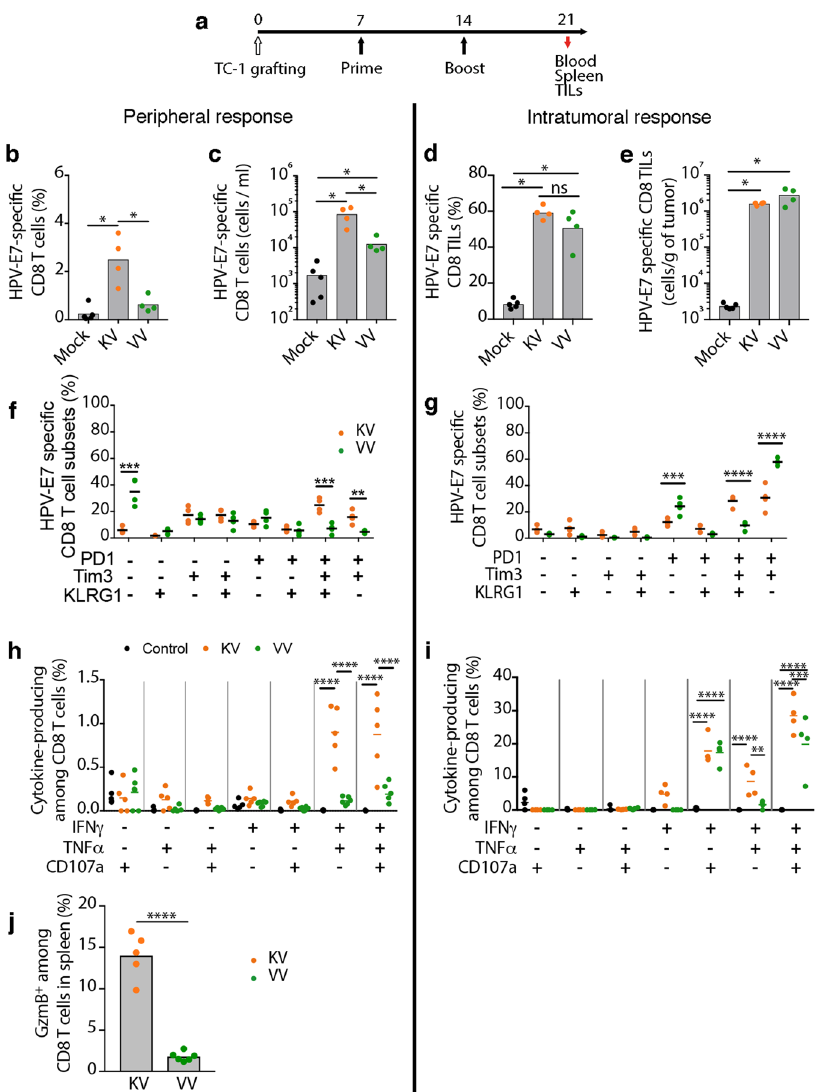
Fig. 2 Priming with KISIMA-HPV improves functionality of intratumoral HPV-speci fi c T cells. a – j C57BL/6J mice were injected s.c. with TC-1 cells on day 0 and vaccinated with KISIMA-HPV (s.c.) or VSV-GP-HPV (i.v.) on day 7 and 14. Blood, spleen and tumors were harvested on day 21 for fl ow cytometric analysis. a Schematic of experimental plan. b , d Frequency and ( c , e ) number of HPV-E7-speci fi c CD8 + T cells were measured by fl ow cytometry in ( b , c ) blood and in ( d , e ) tumors. Two-tailed Mann – Whitney test (*, p < 0.05). f , g Proportions of ( f ) peripheral and ( g ) intratumoral HPV-E7- speci fi c CD8 + T cells expressing activation and exhaustion markers are depicted ( n = 5 for mock, n = 4 for each treatment group). Two-way ANOVA with Sidak ’ s multiple comparison (***, p < 0.001; ****, p < 0.0001). h , i Frequencies of HPV-E7-speci fi c CD8 + T cells secreting different cytokines upon ex vivo restimulation among ( h ) splenic ( n = 5 for mock and KV, n = 6 for VV) and ( i ) intratumoral ( n = 5 for mock, n = 4 for each treatment group) CD8 + T cells are shown. Two-way ANOVA with Sidak ’ s multiple comparison (**, p < 0.01; ***, p < 0.001; ****, p < 0.0001). j Frequencies of granzyme B expressing cells among splenic CD8 + T cells is shown ( n = 5 for KV and n = 6 for VV). One-way ANOVA with Tukey ’ s multiple comparisons (**** p < 0.0001). All data shown as mean ± SEM. Studies ( b – e , j ) were repeated once. Studies ( f - i ) were performed once. Source data and p -values are provided in the Source Data